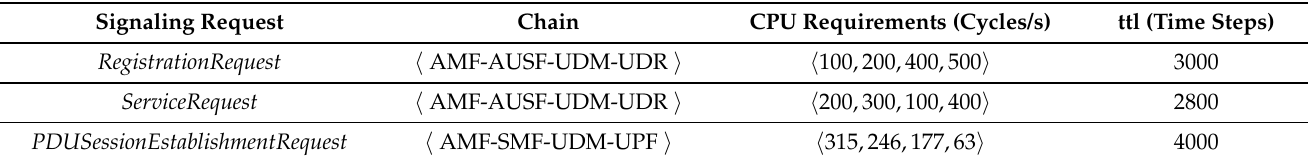
Table 1. Parameters for signaling requests.